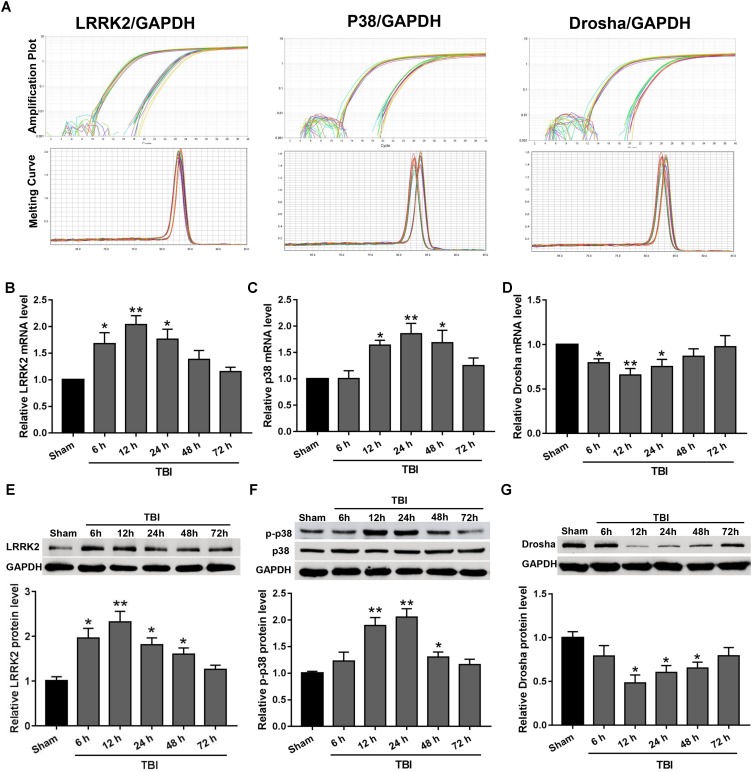
The mRNA and protein expression levels of LRRK2, p38, and Drosha in the peri-injury cortex after TBI. (A) Amplification and melting temperature curves for LRRK2, p38, Drosha (right), and GAPDH (left) were obtained to identify the cycle thresholds and confirm the specificity of real-time PCR amplification. The relative mRNA expression levels of (B) LRRK2, (C) p38, and (D) Drosha were evaluated using the ratio of the number of target mRNAs to the GAPDH mRNA. Western blot was performed to determine the protein levels of endogenous (E) LRRK2, (F) p38, and (G) Drosha in the sham and TBI groups at 6, 12, 24, 48, and 72 h. The relative densities of each protein were normalized to the sham group. The results show that the expression levels of LRRK2 and p-p38 were increased at both the mRNA and protein levels after TBI, whereas Drosha expression exhibited the opposite trend. Statistical analyses were performed using one-way analysis of variance (ANOVA) followed by Dunnett’s post hoc test. N = 6 for each group per time point. Data are expressed as the mean ± SD. ∗P < 0.05, ∗∗P < 0.01 vs. sham.